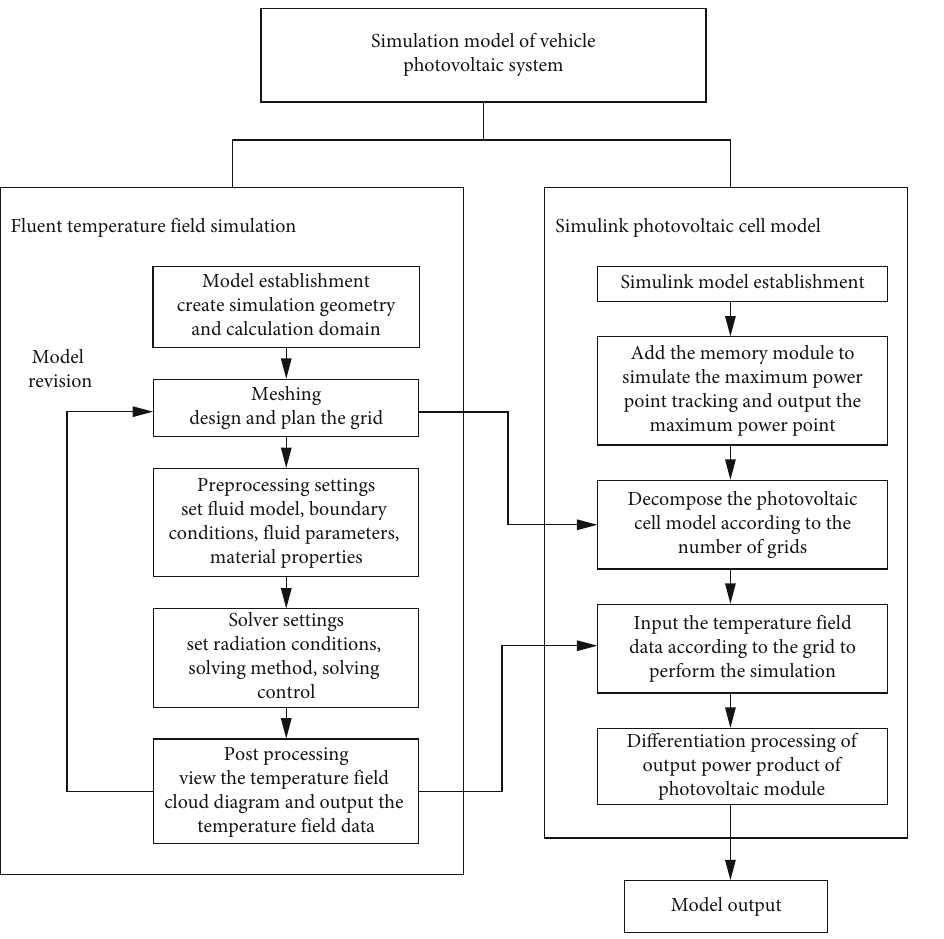
Figure 2: Structure of the simulation model.